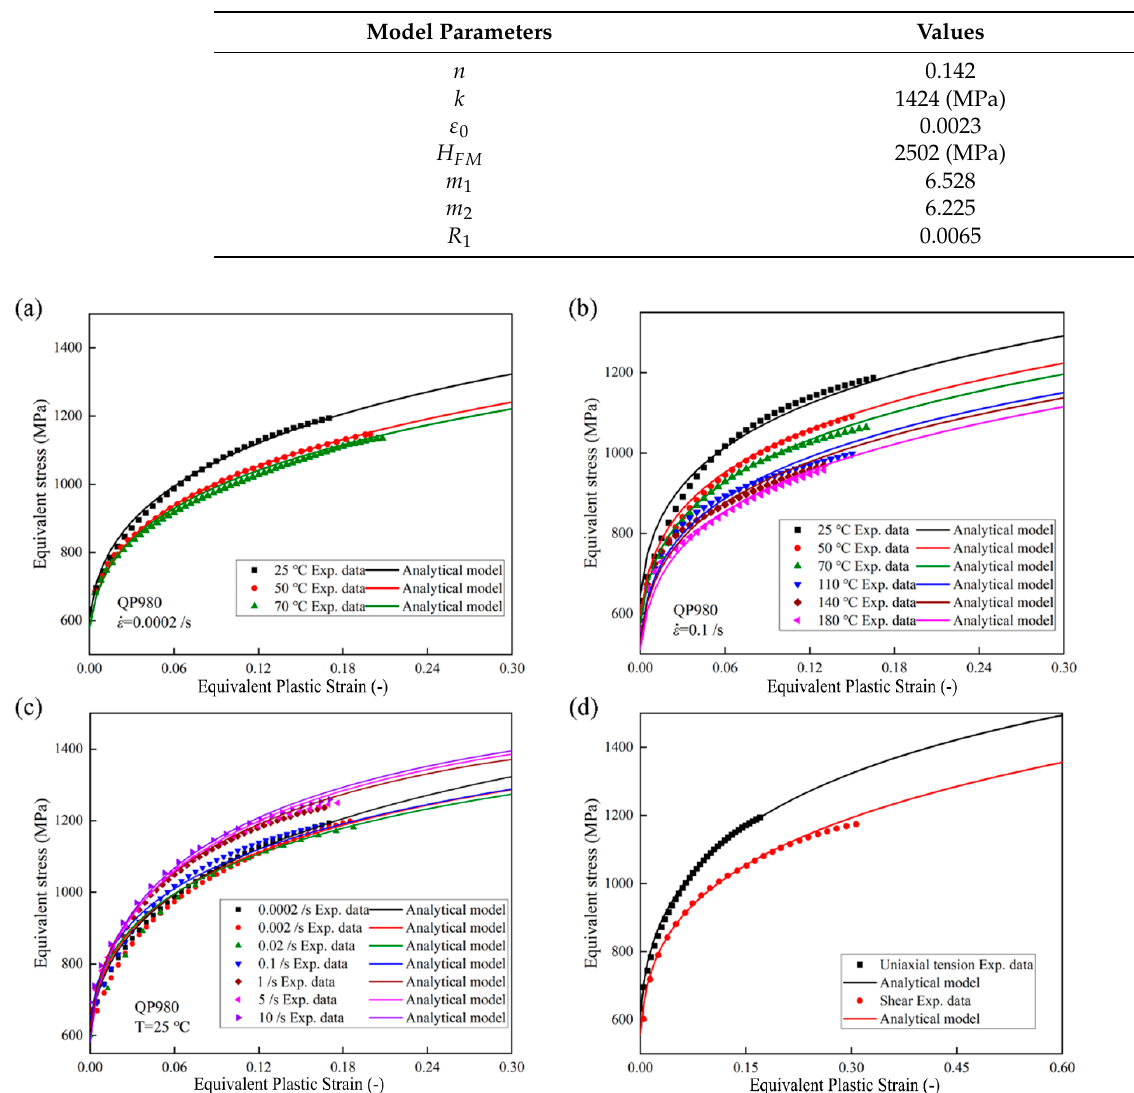
Table 7. Parameters in the stress-strain model.